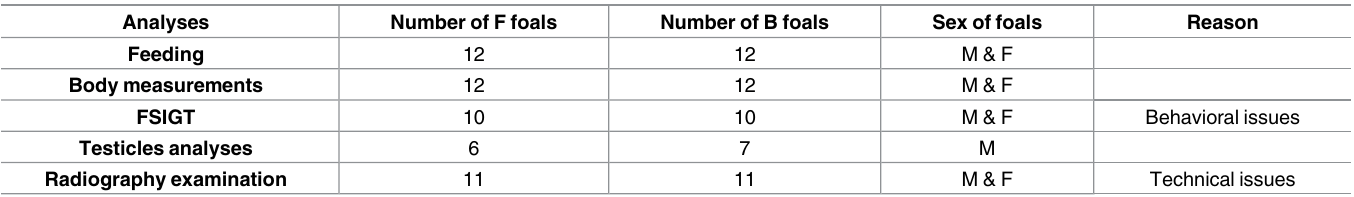
Table 5. Summaryof the number of foals included in each